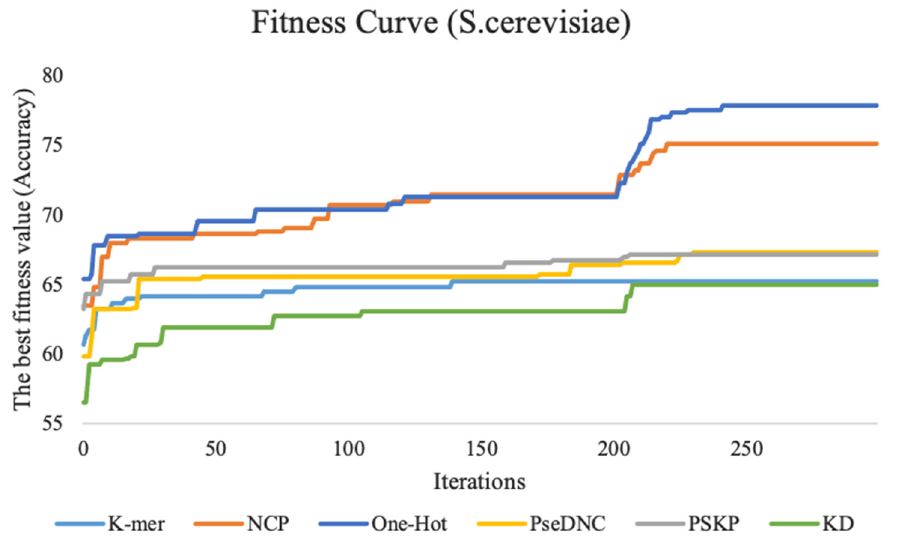
Figure 3. The fitness curves of six feature descriptors on the S. cerevisiae dataset. K-mer represents the fitness curve for nucleotide frequency, KD represents the fitness curve for nucleotide density, PseDNC represents the fitness curve for pseudo dinucleotide composition, PSKP represents the fitness curve for position-specific k-nucleotide propensity, and NCP represents the fitness curve for nucleotide chemical property. Additionally, the vertical coordinates represent the accuracy, and the horizontal coordinates represent the number of iterations.